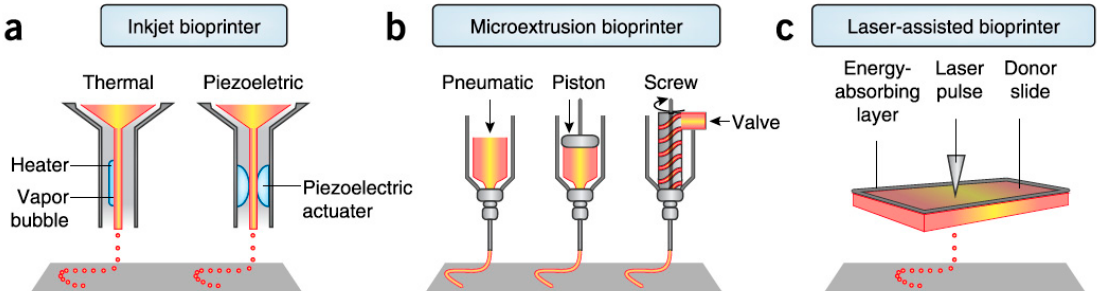
Figure 5. Illustration of three major categories of 3D bioprinting. ( a ) Inkjet bioprinting, in which